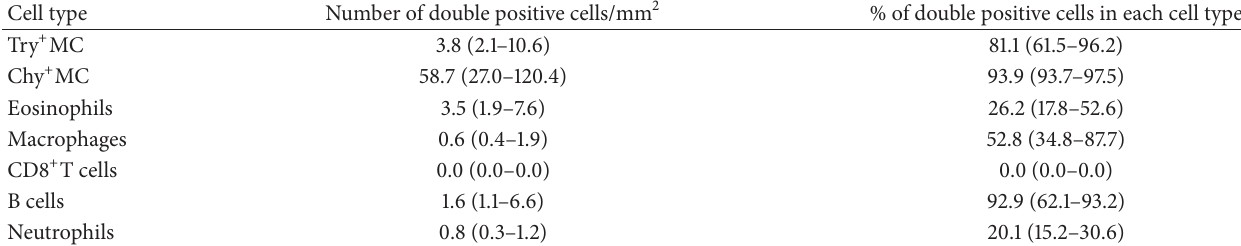
Figure 3: Flow cytometry analysis of the expression of interferon- (IFN-) 𝜆 1 in dispersed human skin cells. (a) showed a representative graph of the changes in the mean fluorescence intensity (MFI) of IFN- 𝜆 1 in CD14 + cells (macrophages), CD16 + cells (neutrophils), CD16 − (eosinophils), CD19 + cells (B cells), and CD34 − CD117 + Fc 𝜀 RI 𝛼 + cells (mast cells) of skin tissue. Gate represents gating strategy. (b) represents a boxplot of the expression of IFN- 𝜆 1 in dispersed skin cells, which indicates the median (horizontal line), interquartile range, the largest, and smallest values other than outliers (whiskers) and the outliers (O). Each piece of data represented a group of minimum 6 subjects. 𝑃 < 0.05 was taken as statistically significant. Table 3: The number of IFN- 𝜆 1 expressing cells (double positive cells)/mm 2 and the percentage of IFN- 𝜆 1 expressing cells in each cell type examined. Data shown are the median (range) value from 6 different donors. Positively stained cells in each section were counted for more than 30 fields (magnification ×